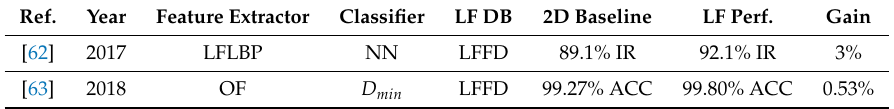
Table 6. Summary of sub-aperture-based face recognition methods. The abbreviations used in this table: IR—identification rate; ACC—accuracy; LFLBP—light-field local binary pattern;